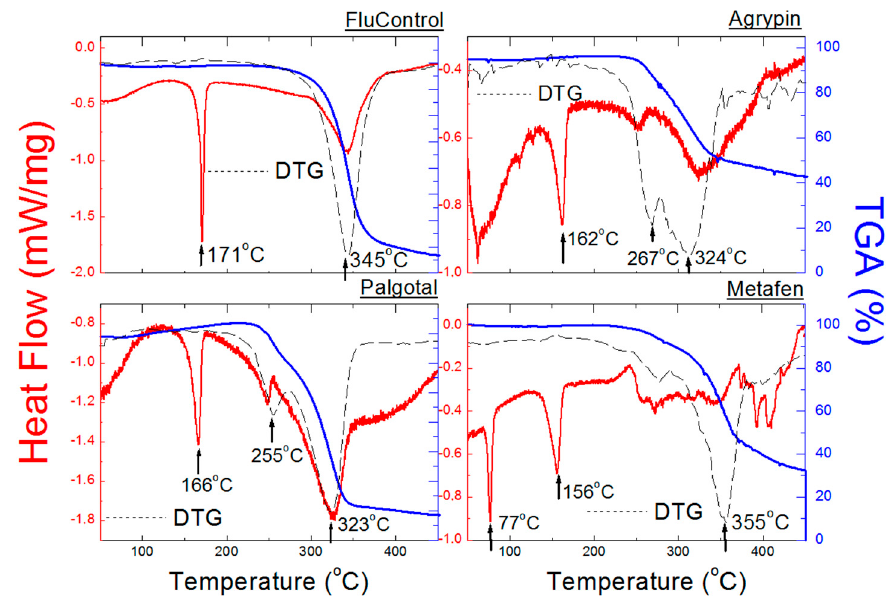
Figure 14. DSC and TGA / DTG curves of the drugs Palgotal, Metafen, Agrypin, and FluControl containing ACP and other APIs.